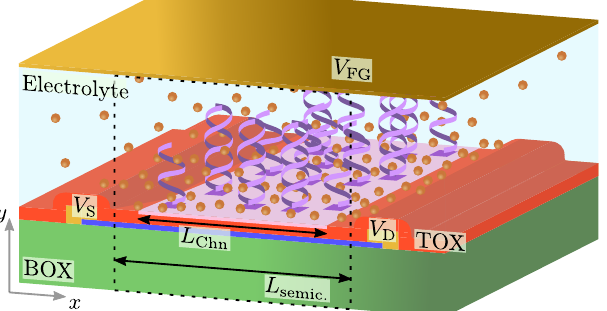
Figure 2. MoS 2 -based DNA BioFET outline. The dashed line determines the simulated